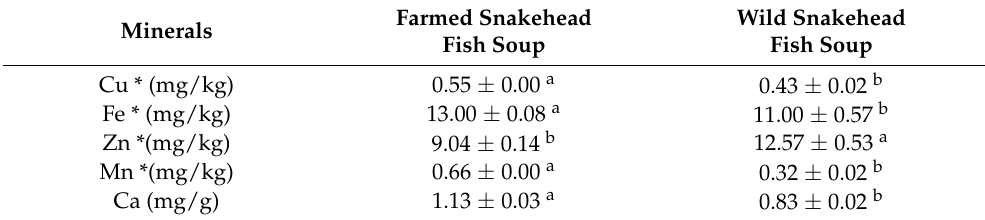
Table 5. Mineral composition of soup made from farmed and wild snakehead fish. Minerals